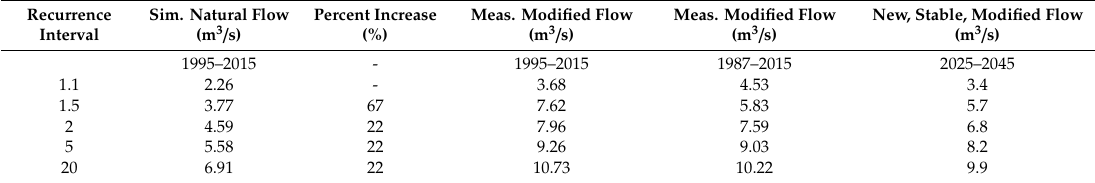
Table 4. Recurrence intervals used to estimate a new, stable, modified flow